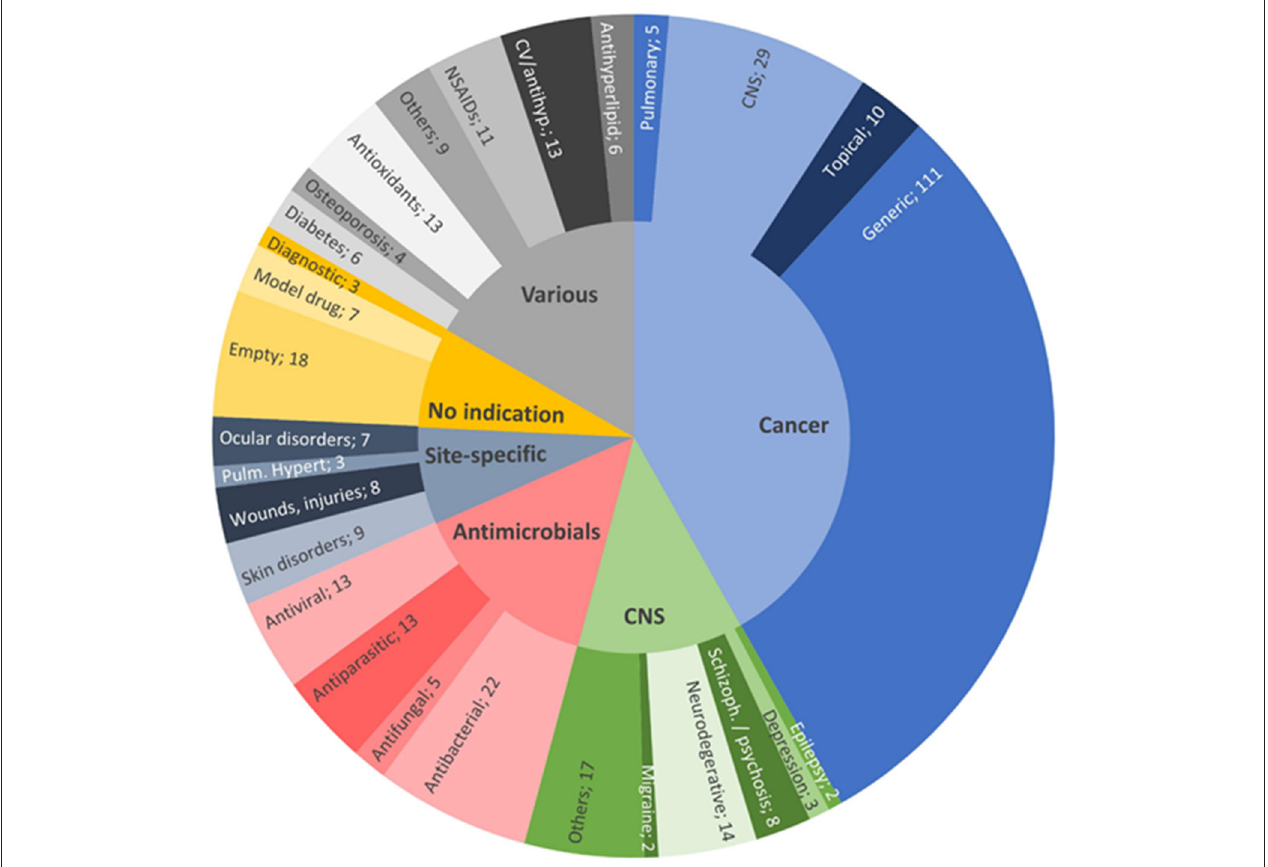
FIGURE 1 | Distribution of the reviewed publications between 2013 and 2020 on NLCs and SLNs, by therapeutic field: anticancer therapies (41.8%, light blue); various indications (16.7%, gray); antimicrobials (14.3%, pink); CNS diseases, excluding cancer and infection (12.4%, green); nanovehicles not intended for any specific therapeutic area (7.5%, yellow); and site-specific treatments (7.3%, dark blue). Reproduced with permission from Frontiers in Molecular Biosciences (Montoto et al.,